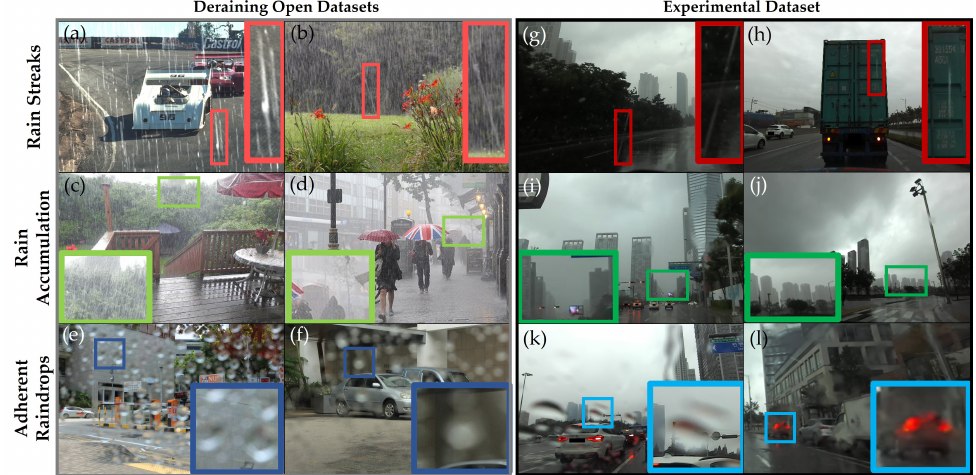
Figure 1. Difference in rain effects between open datasets and experimental dataset: ( a – f ) deraining open datasets [10,11,15]; ( g – l ) our experimental dataset. Rain streaks (1st column) are mostly invisible in the images in the experimental data compared with the open dataset. Rain accumulation (2nd col- umn) occurs at a far distance with no specific impacts on nearer objects. Instead, both artificial and actual adherent raindrops (3rd column) distort the images and deteriorate visibilities. Best viewed with